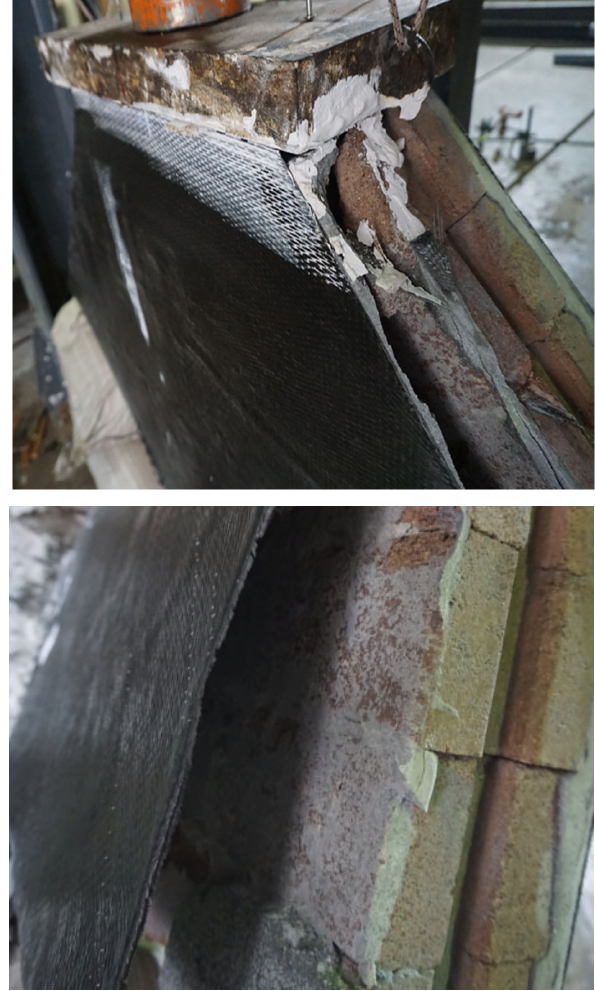
Figure 14. Debonding of CFRP composites from CS mortar at load 450 kN.